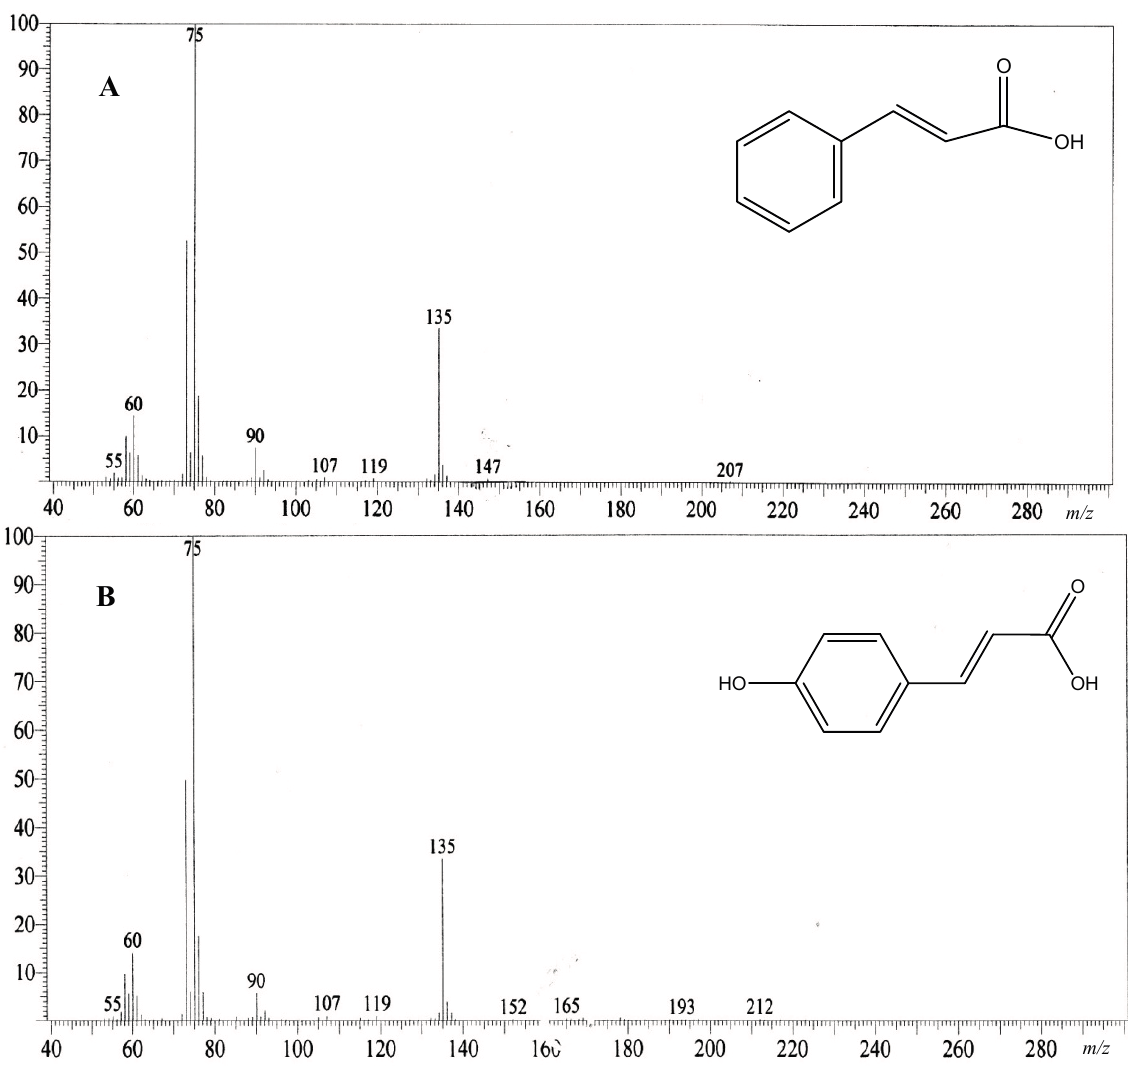
Figure 3. Mass spectrum of active anticoagulant Subfraction B. Subfraction B as active anticoagulant fraction was purified through a series of bioassay-guided fractionation. The anticoagulant activity was determined through prolongation of activated partial thromboplastin time (APTT). Cinnamic acid ( A , m/z 147; major component) and para -hydroxycinnamic acid ( B , m/z 165; minor component) were identified from the mass spectrum